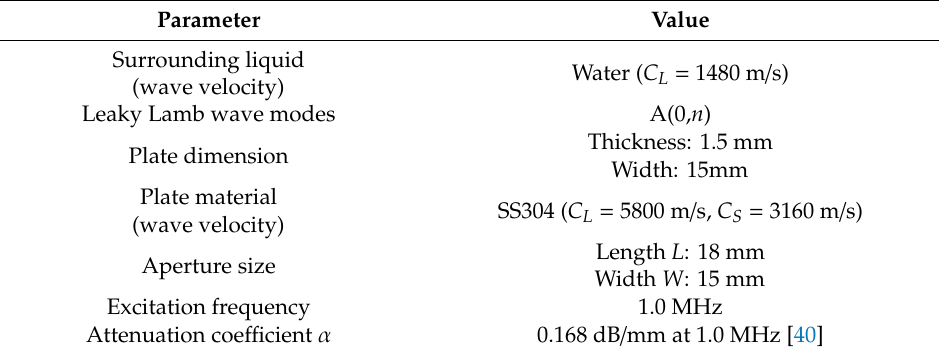
Table 1. Rayleigh–Sommerfeld integral (RSI) model details.